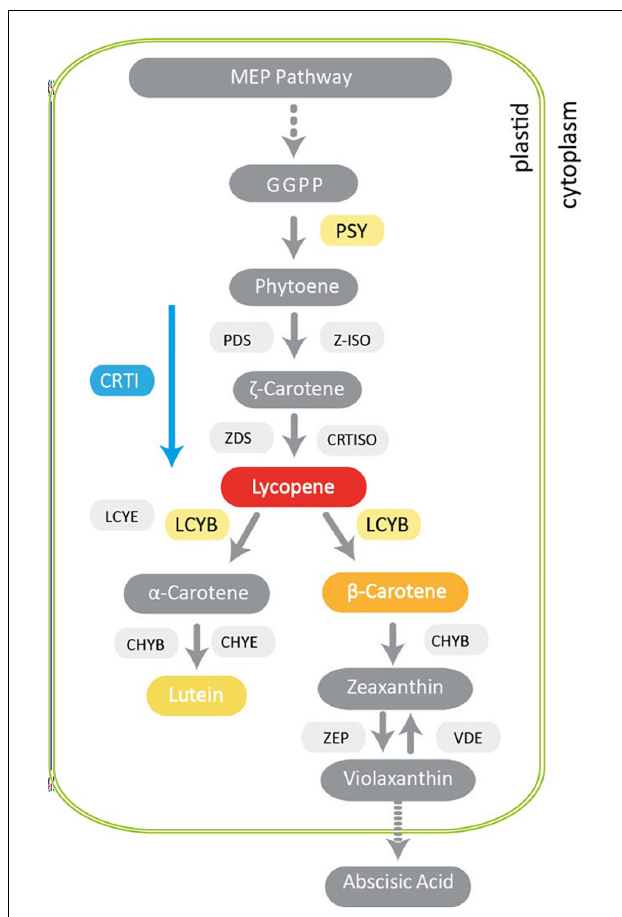
FIGURE 1 | The main steps of carotenoid biosynthesis and related pathways in plants. The methylerythritol 4-phosphate (MEP) pathway produces isoprenoids in plastids leading to the production of geranylgeranyl pyrophosphate (GGPP). Phytoene synthase (PSY) is the first enzyme in the carotenogenic pathway and produces phytoene. In plants, phytoene is then desaturated and isomerized by phytoene desaturase (PDS), ζ –carotene desaturase (ZDS), ζ –carotene isomerase (Z-ISO) and prolycopene isomerase (CRTISO) forming lycopene. In bacteria, these reactions are carried out by a single multifunctional enzyme, phytoene desaturase (CRTI). β -carotene is produced if lycopene is cyclized only by lycopene β -cyclase (LCYB) whilst α -carotene is produced if both LCYB and lycopene ε -cyclase (LCYE) are involved. β -carotene hydroxylase (CHYB) and ε -carotene hydroxylase (CHYE) produce lutein. CHYB produces zeaxanthin, which can be converted into violaxanthin by zeaxanthin epoxidase (ZEP). The reverse step can be carried out by violaxanthin de-epoxidase (VDE). Violaxanthin is the precursor of abscisic acid. Dotted arrows indicate multiple enzymatic reactions. Solid gray arrows represent different steps of the carotenogenic pathway. The blue arrow indicates consecutive desaturations carried out by bacterial